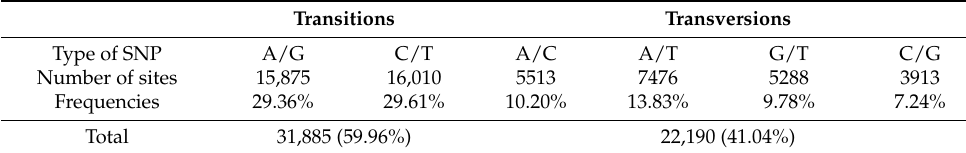
Figure 1. GBS-generated SNP marker characterization. ( a ) Number of SNPs per chromosome; ( b ) minor allele frequency (MAF); ( c ) gene diversity (GD); ( d ) polymorphic information content (PIC). Table 2. Summary result of the SNP